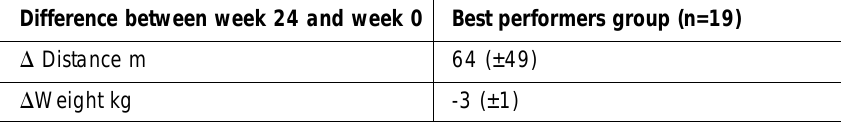
Table 2: Change in distance walked and weight after 24